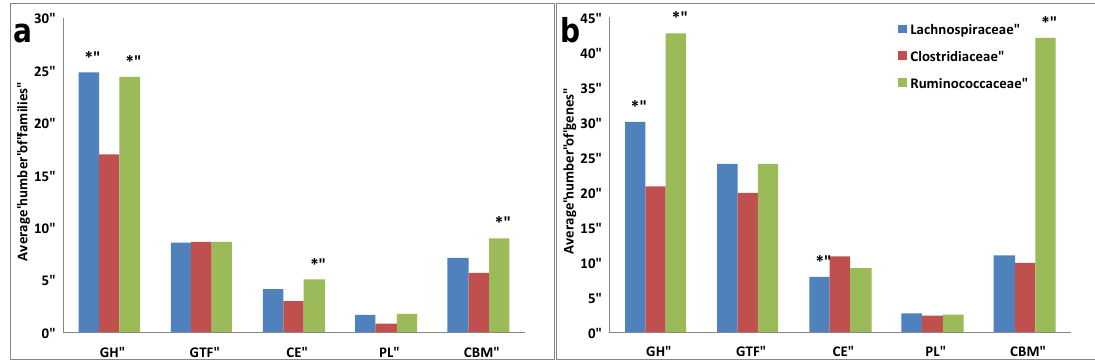
Figure 3. Comparison of Carbohydrate-Active enZymes (CAZy) with respect to abundance in the genomes of Lachnospiraceae, Clostridiaceae, and Ruminococcaceae. ( a ) Average numbers of CAZy families per group. ( b ) Average numbers of CAZy genes per group. CAZy enzyme classes indicated as follows: GH = glycoside hydrolase, GTF = glucosyltransferase, CE = carbohydrate esterase, PL = polysaccharide lyase. (*) Groups showing significant differences in either one-way ANOVA testing (for data with a normal distribution based on the Shapiro-Wilks test) or the best fit between negative binomial and Poisson models as described